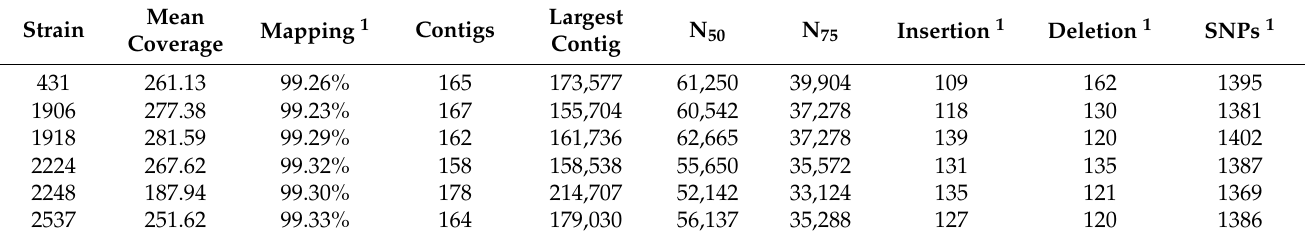
Table 2. Core genomic characteristics of the six Mycobacterium tuberculosis Lineage 3 strains from Northern Brazil based on the outputs of the reference-based MTBseq pipeline, Prokka annotation and de novo assembly analysis.